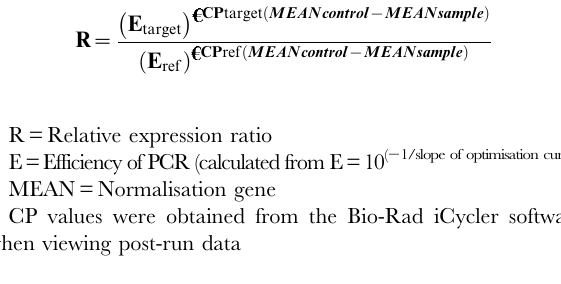
Figure S1 FACS analysis. Cell cycle phase composition was analysed by FACS. The four unsynchronysed cell lines present similar percentages of diploid cells in G1, S and G2. Figure S2 Effects of the 5-azacytidine on Control 1 cells. Metaphase spreads obtained from Control 1 after the demethyl- ating treatment show variable extent of decondensation or stretching of the chromosome 1 juxtacentromeric heterochromatin (white arrows), similar to what normally observed in ICF cells. Panels C, D and E show dual colour FISH images with D1Z1 in